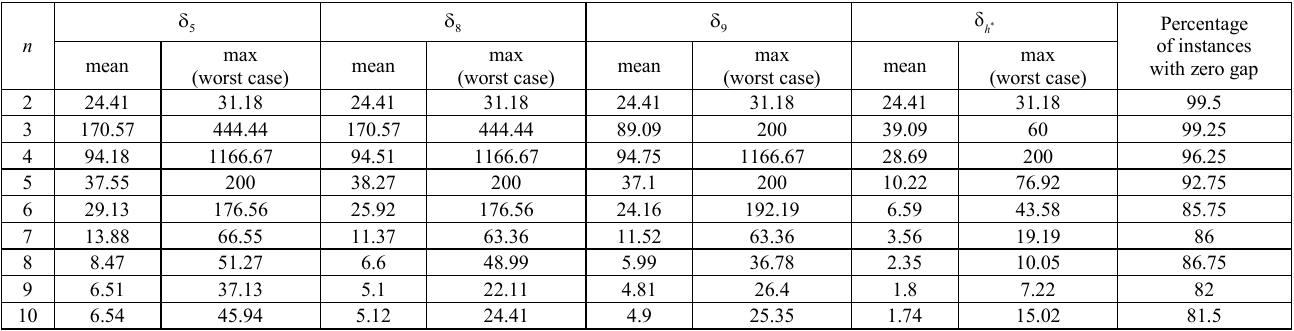
T HE A CCURACY OF THE H YPER -